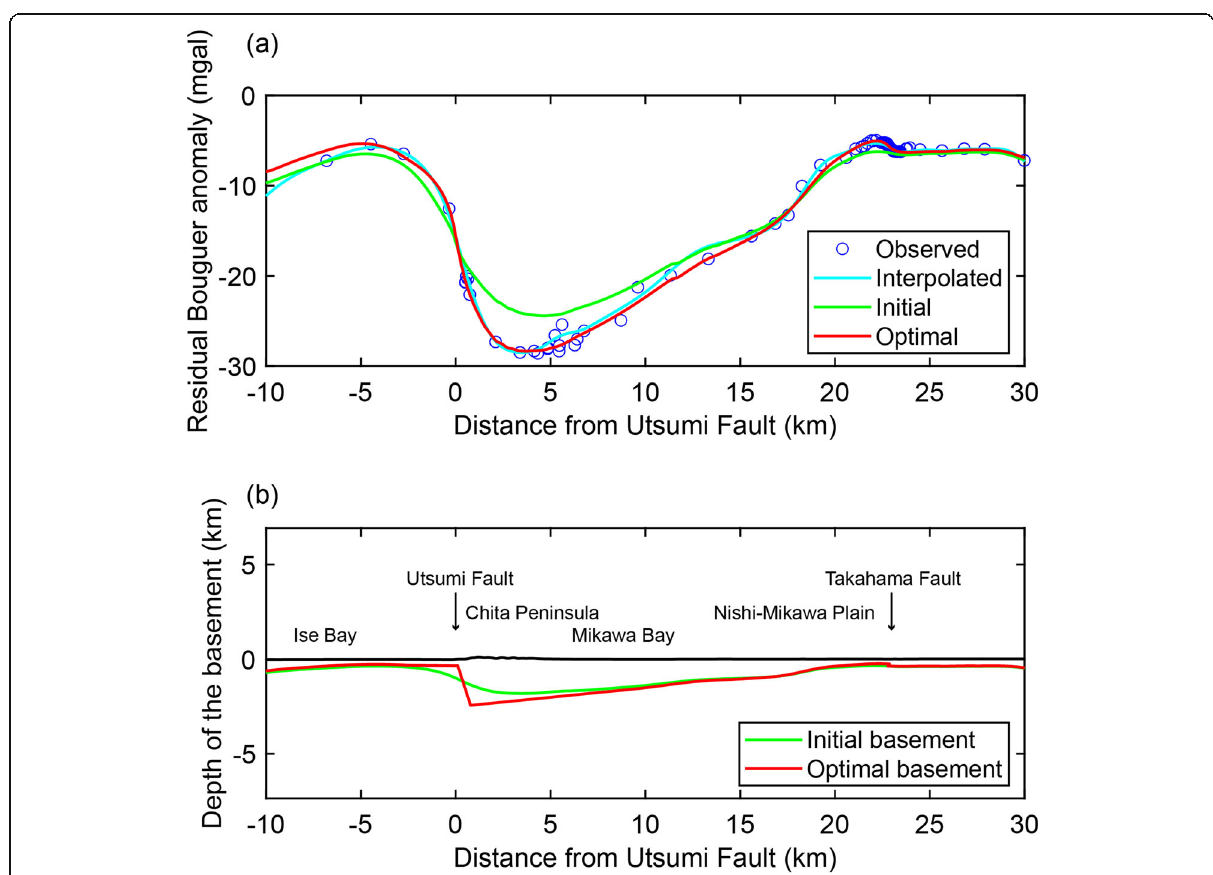
Fig. 8 Profiles of the Bouguer anomaly ( a ) and the topography of the basement surface ( b ). a The observed and interpolated residual Bouguer anomalies are represented by the open circles and cyan line, respectively. The interpolated residual Bouguer anomalies come from that of the Fig. 3d. The green line and red line represent the calculated Bouguer anomaly from the initial model (green in b ) and the optimum model (red in b ) using the 2D Talwani ’ s method. b The green line represents the initial model extracted from the gravity basement model (Fig. 7) along the survey line. The red line represents the optimum basement model obtained by selecting the best parameters (see Table 2). The black line represents the elevation of the ground surface. The origin of the x -axis is set as the tip of the Utsumi Fault in both a and b